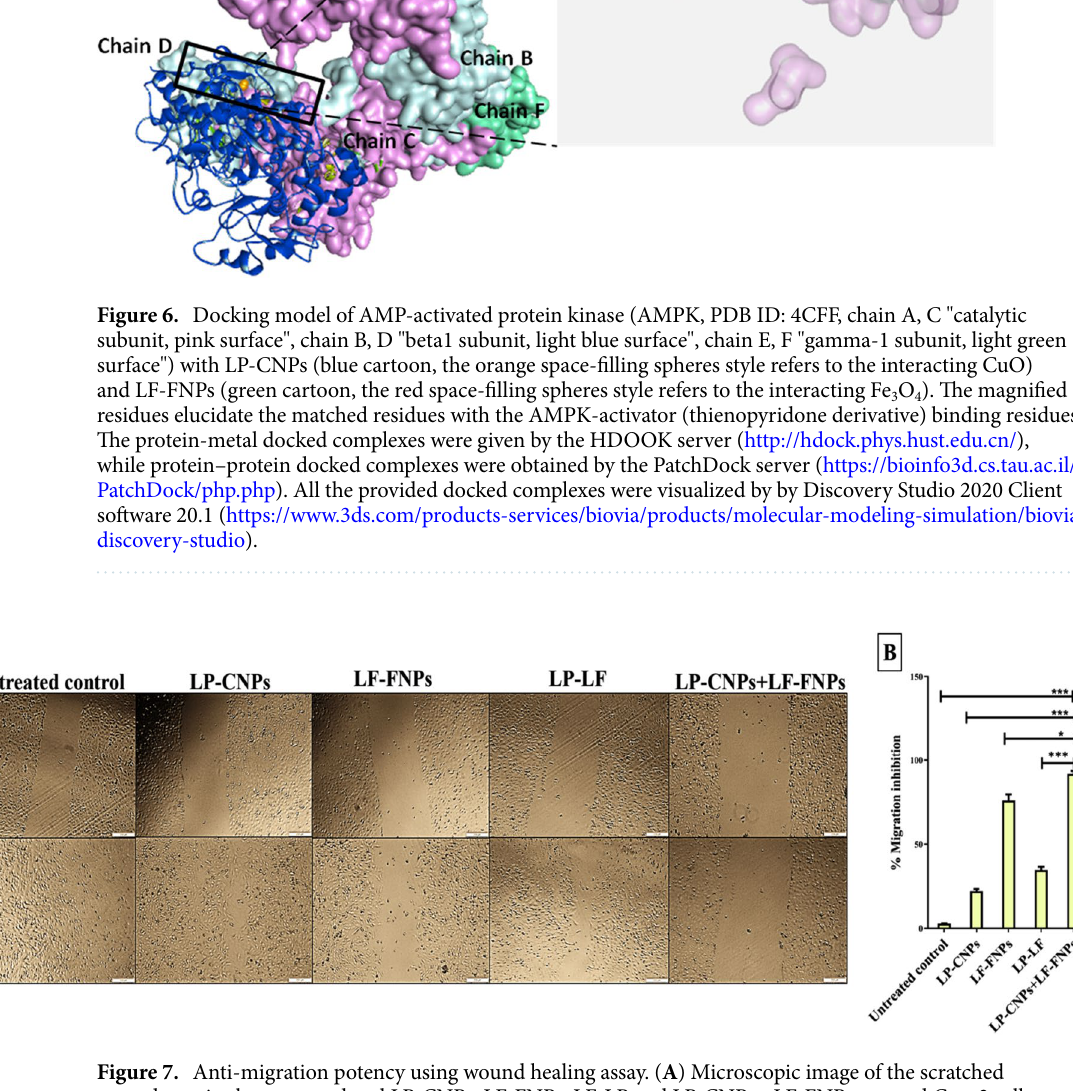
the activities of cathepsin B and MMP-9 for further explanation of their anti-migration influences against the